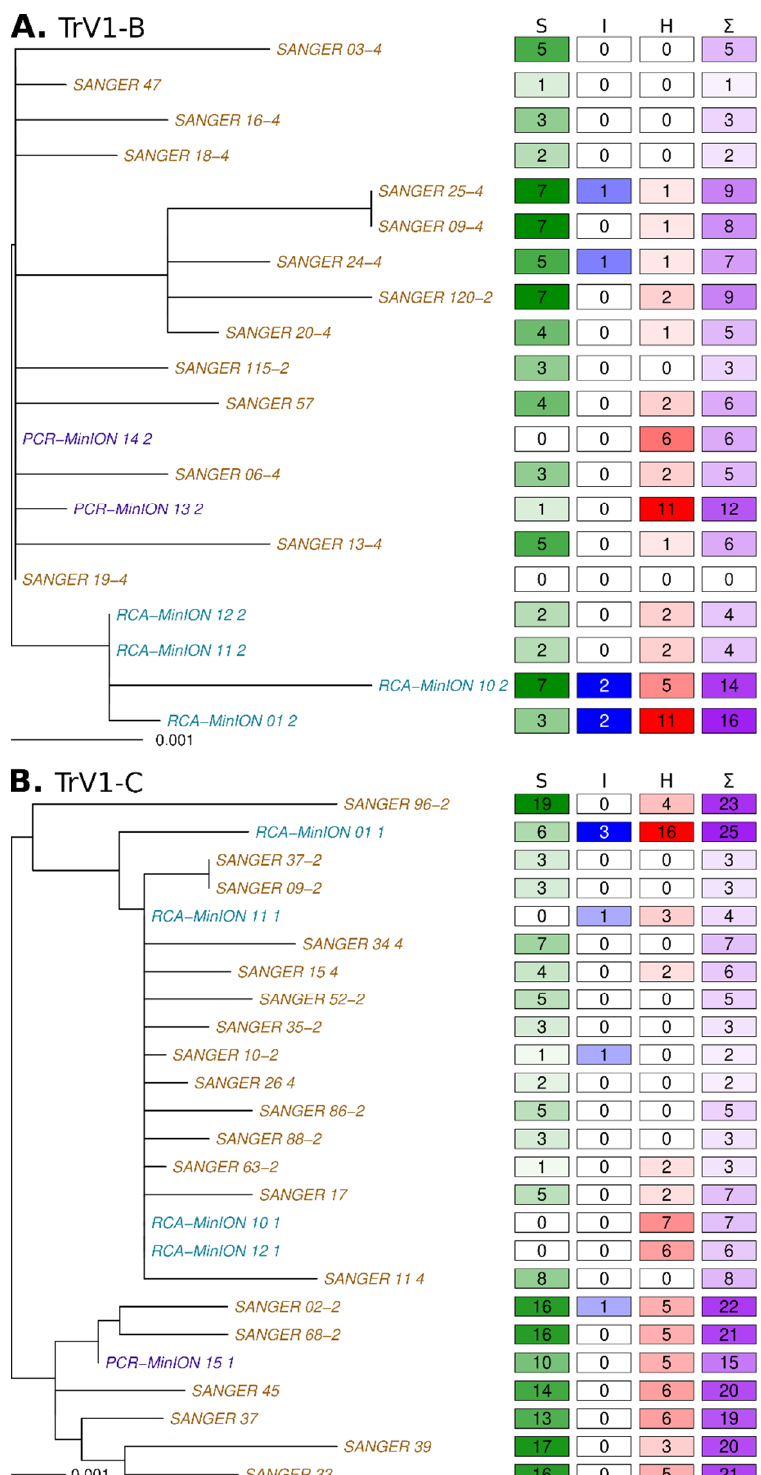
Figure 2. Maximum likelihood phylogenetic tree of all the sequences of the TrV1-B ( A ) and TrV1-C ( B ) strains obtained after Sanger sequencing (brown tips) or MinION sequencing followed by read assemblies (blue and purple tips for the RCA-MinION and PCR-MinION procedures respectively) on the left along with a matrix presenting the number of mutation relative to the Sanger consensus on the right. The numbers in the four columns present the substitutions (S), INDELs (I), HLVs (H) and the sum (Σ) of all these variations.